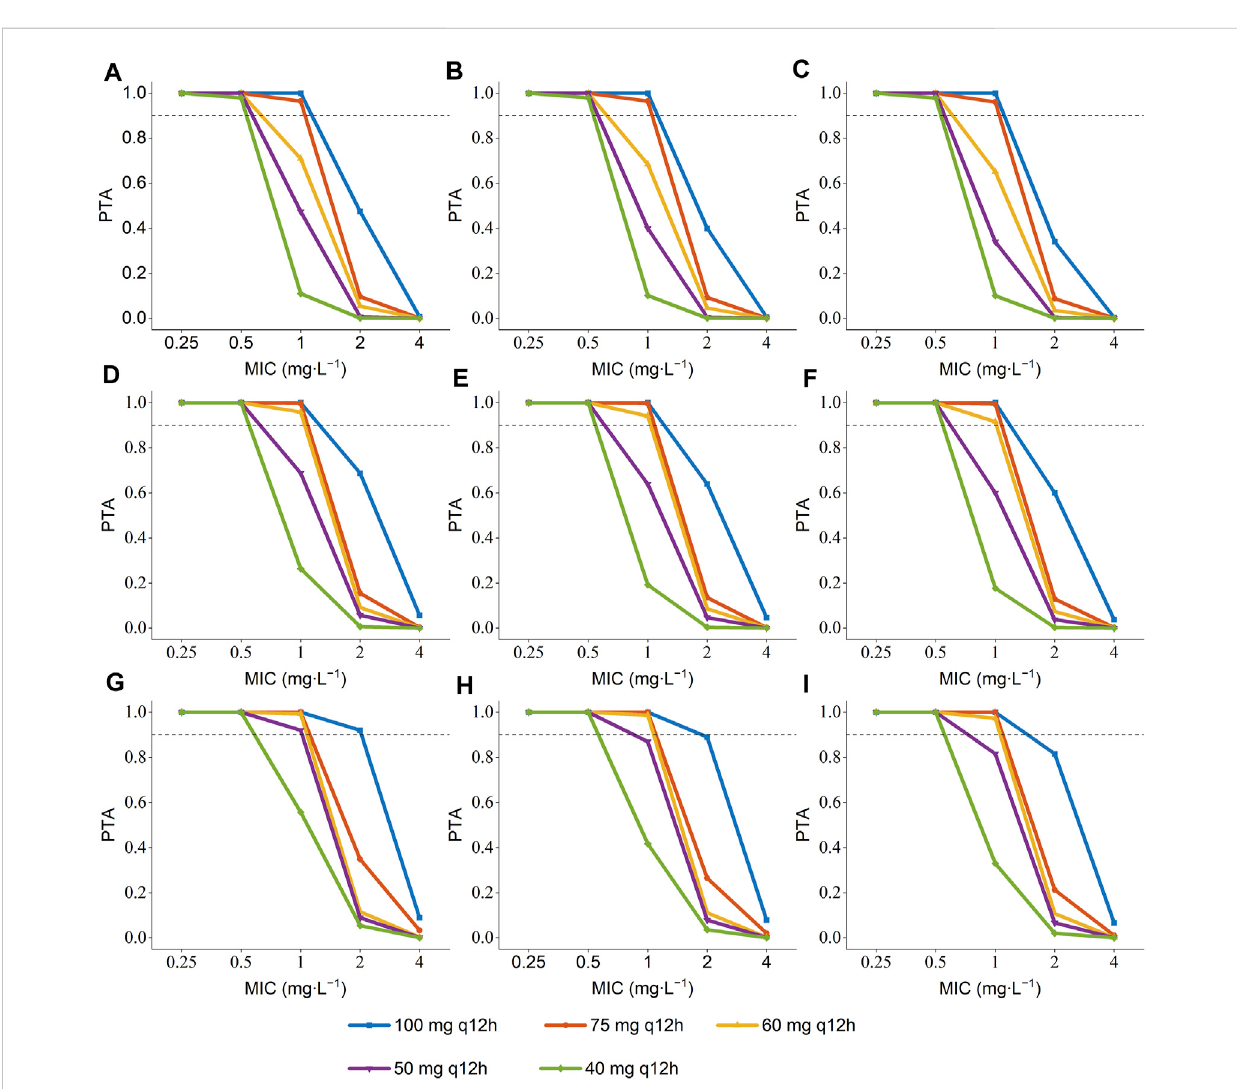
FIGURE 3 Probabilityoftargetattainment(PTA)ofAUC/MIC ≥ 50forthesimulatedpolymyxinBdosingregimensinpatientsaccordingtodifferentALBandage a . (A) ALB = 23.1 – 24.9 g L -1 , age = 34 years; (B) ALB = 23.1 – 24.9 g L -1 , age = 68 years; (C) ALB = 23.1 – 24.9 g L -1 , age = 93 years; (D) ALB = 25 – 34.9 g L -1 , age = 34 years; (E) ALB = 25 – 34.9 g L -1 , age = 68 years; (F) ALB = 25 – 34.9 g L -1 , age = 93 years; (G) ALB = 35 – 41.5 g L -1 , age = 34 years; (H) ALB